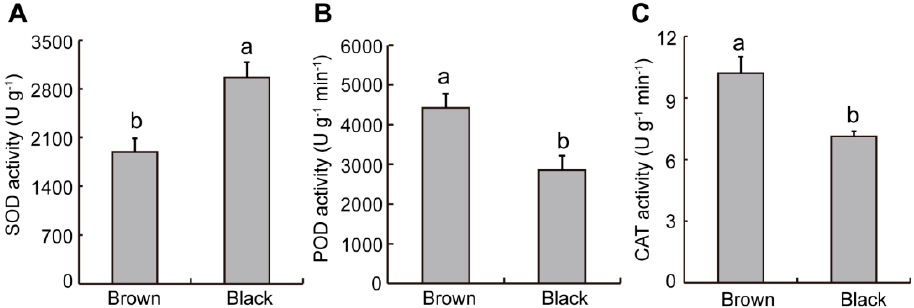
Figure 3. Determination of antioxidant enzyme activity in dimorphic seeds of S. liaotungensis . ( A ) SOD activity. ( B ) POD activity. ( C ) CAT activity. Different letters show significant differences ( t - test, p < 0.05).